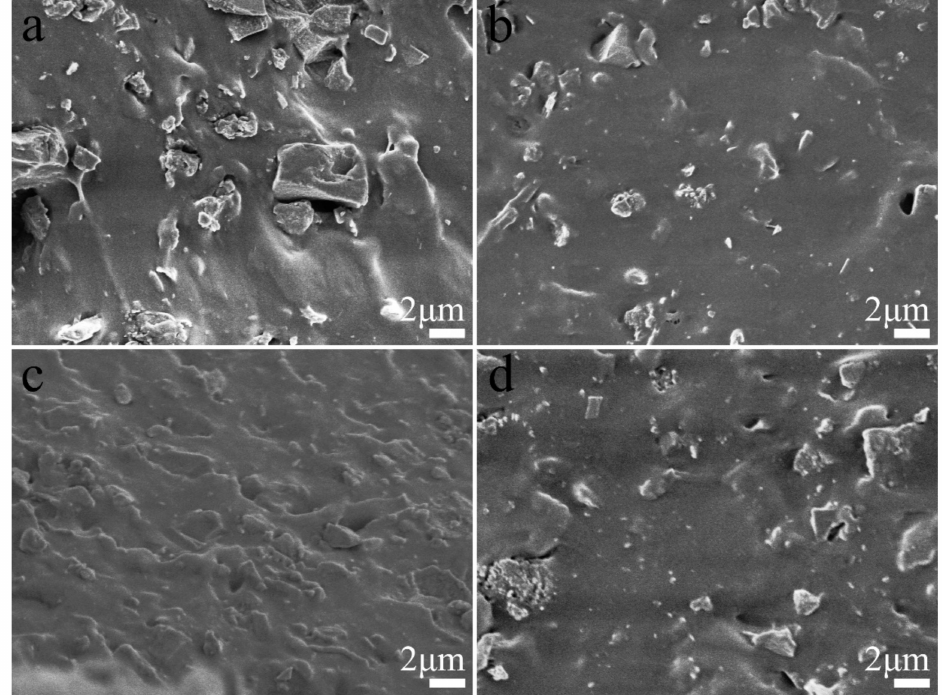
Figure 3. SEM images of the brittle fracture surfaces ( a ) SiCB-NR/BR, ( b ) M 1 SiCB-NR/BR, ( c ) SiCB-MNR 3 /BR, and ( d ) M 2